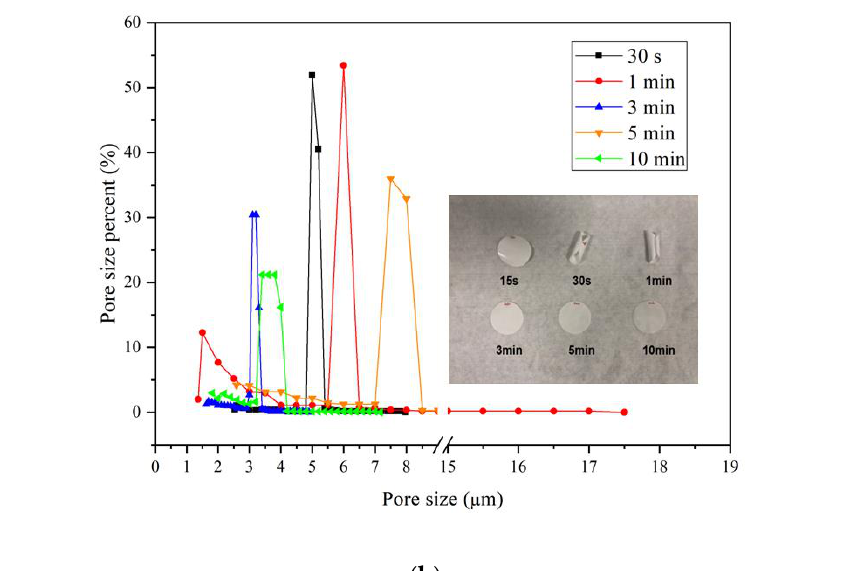
Figure 5. ( a ) SEM images of PVDF membranes prepared with different exposure time of ( A , B ) 15 s, ( C , D ) 30 s, ( E , F ) 1 min, ( G , H ) 3 min, ( I , J ) 5 min and ( K , L ) 10 min. ( b ) Pore size distribution of PVDF